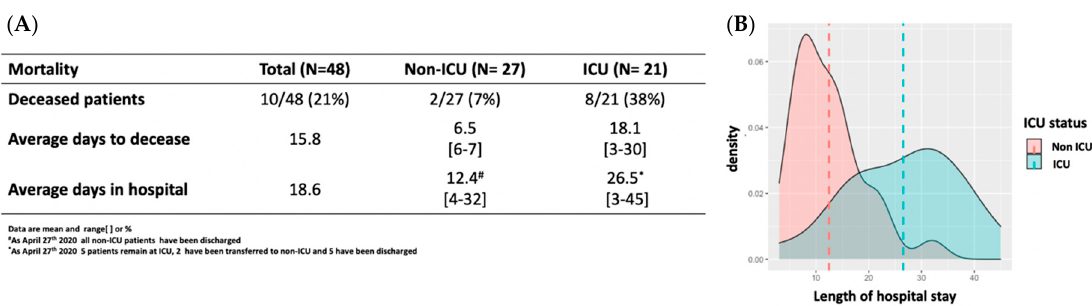
Figure 2. Mortality and length of hospital stay of the 48 COVID-19 patients. ( A ) Mortality, average days to decease and days in the hospital in non-ICU and ICU patients with COVID-19 in Mallorca. ( B ) Density plot of the length of hospital stay showing the average days in the hospital; red is non-ICU patients and green is ICU patients with COVID-19.